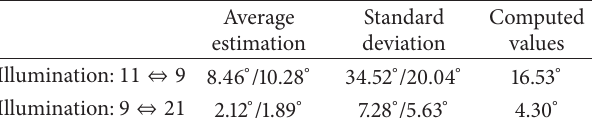
Figure 12: Accuracy comparison for each illumination class.